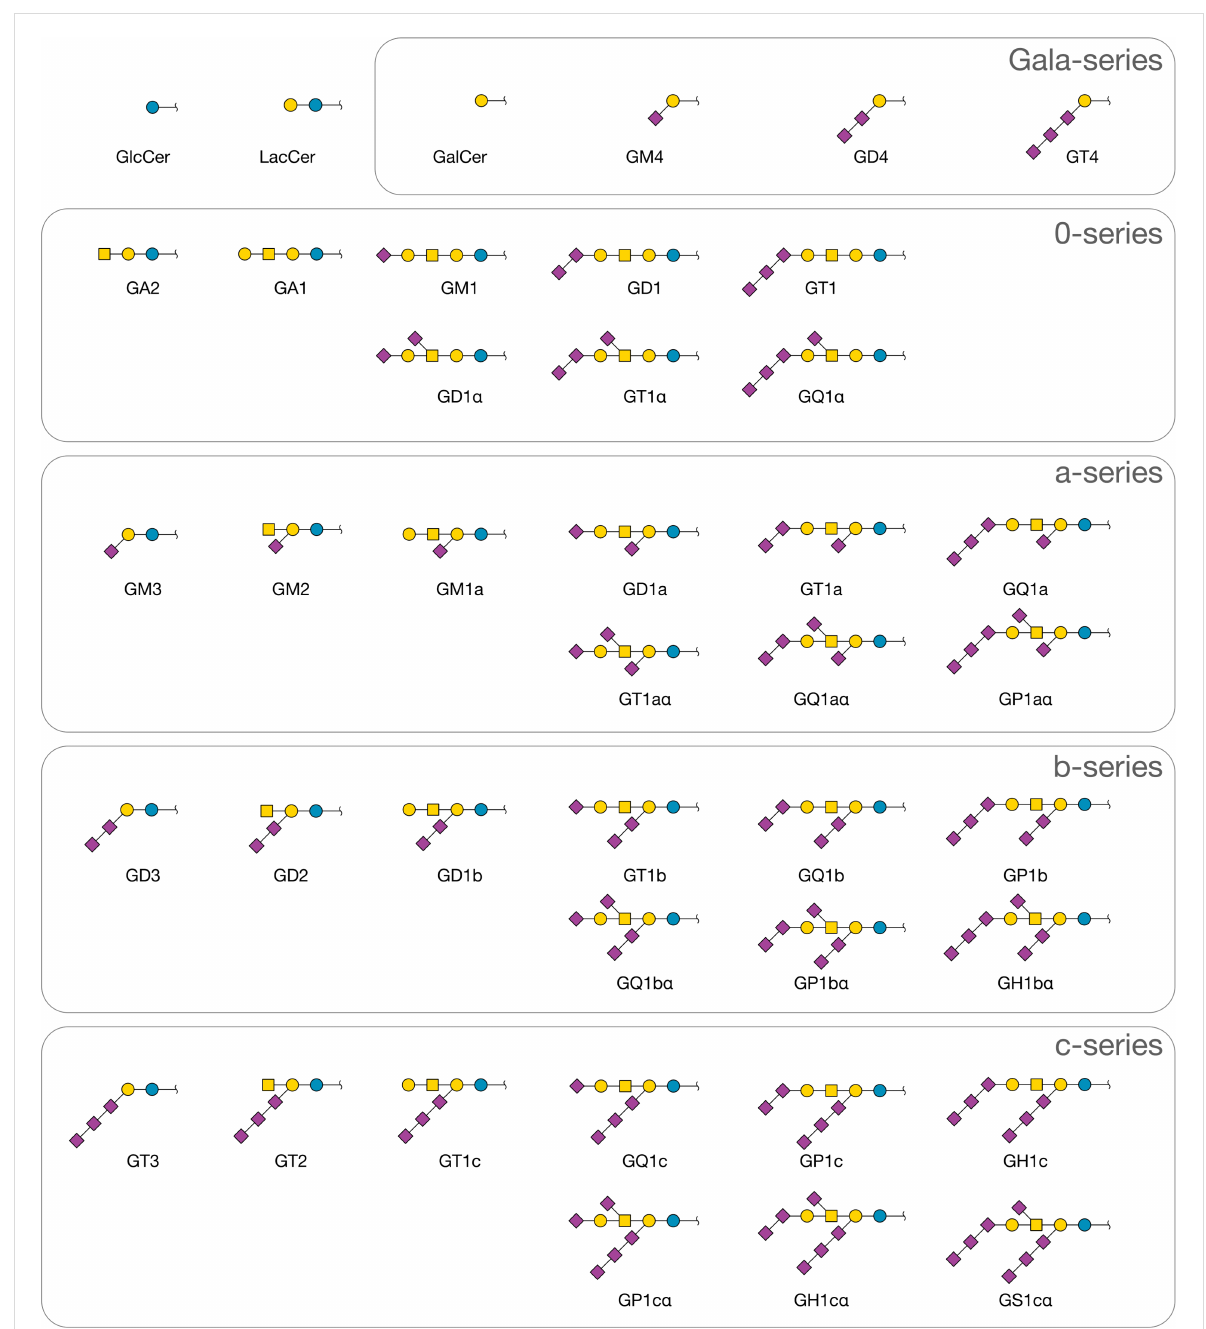
Figure 3: Ganglioside carbohydrates predicted by the model. All structures are linked to ceramide at the base glucose or galactose residue.